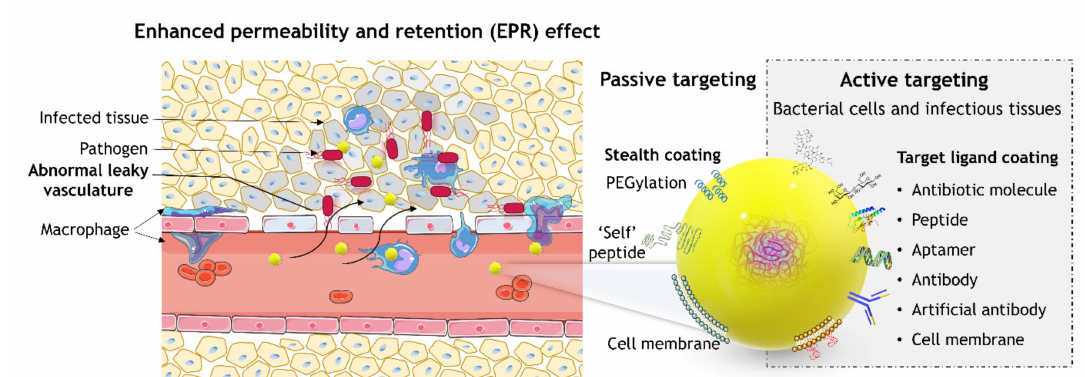
Figure 7. Schematic representation of antibiotic-loaded nanocarriers that passively or actively target infection sites. Both types of nanocarriers firstly reach infection sites through the enhanced permeability retention (EPR) effect caused by infection-induced inflammation (passive targeting). Surface coating strategies have been used to camouflage NPs, preventing opsonization and sequestration by the MPS system for prolonged circulation (stealth coating). Active targeting is then mediated by selective binding between ligand-coated nanocarriers and receptors overexpressed or uniquely expressed by target infection